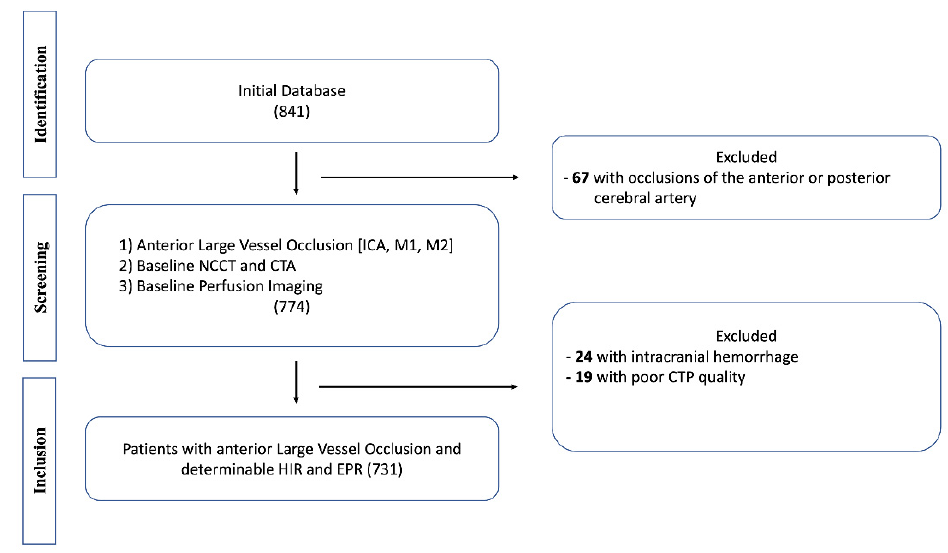
Figure 1. Patient inclusion and exclusion flow chart.